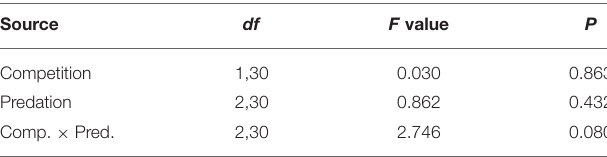
TABLE 1 | ANOVA results for proportion of female Aedes aegypti larvae surviving to adulthood.